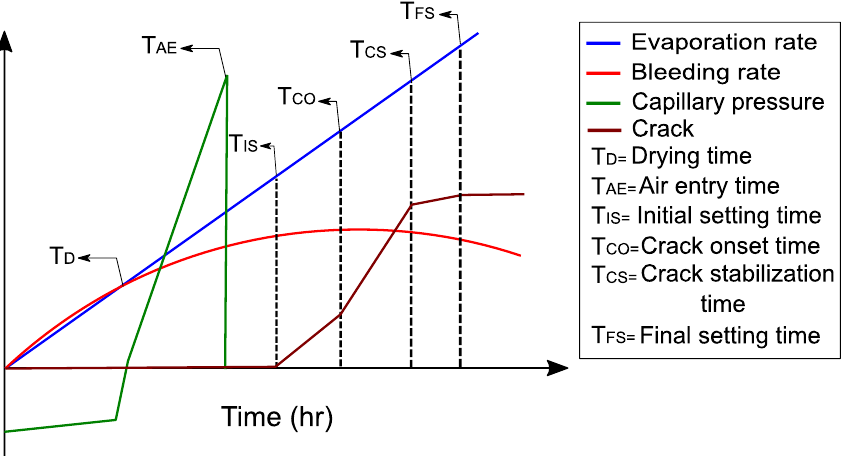
Figure 2. Typical behaviour of plastic shrinkage cracking.